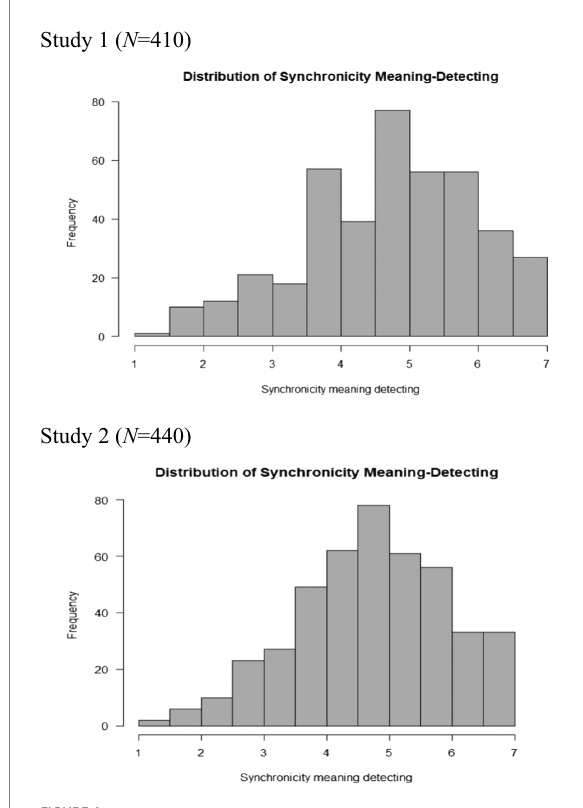
FIGURE 4 The distribution of synchronicity